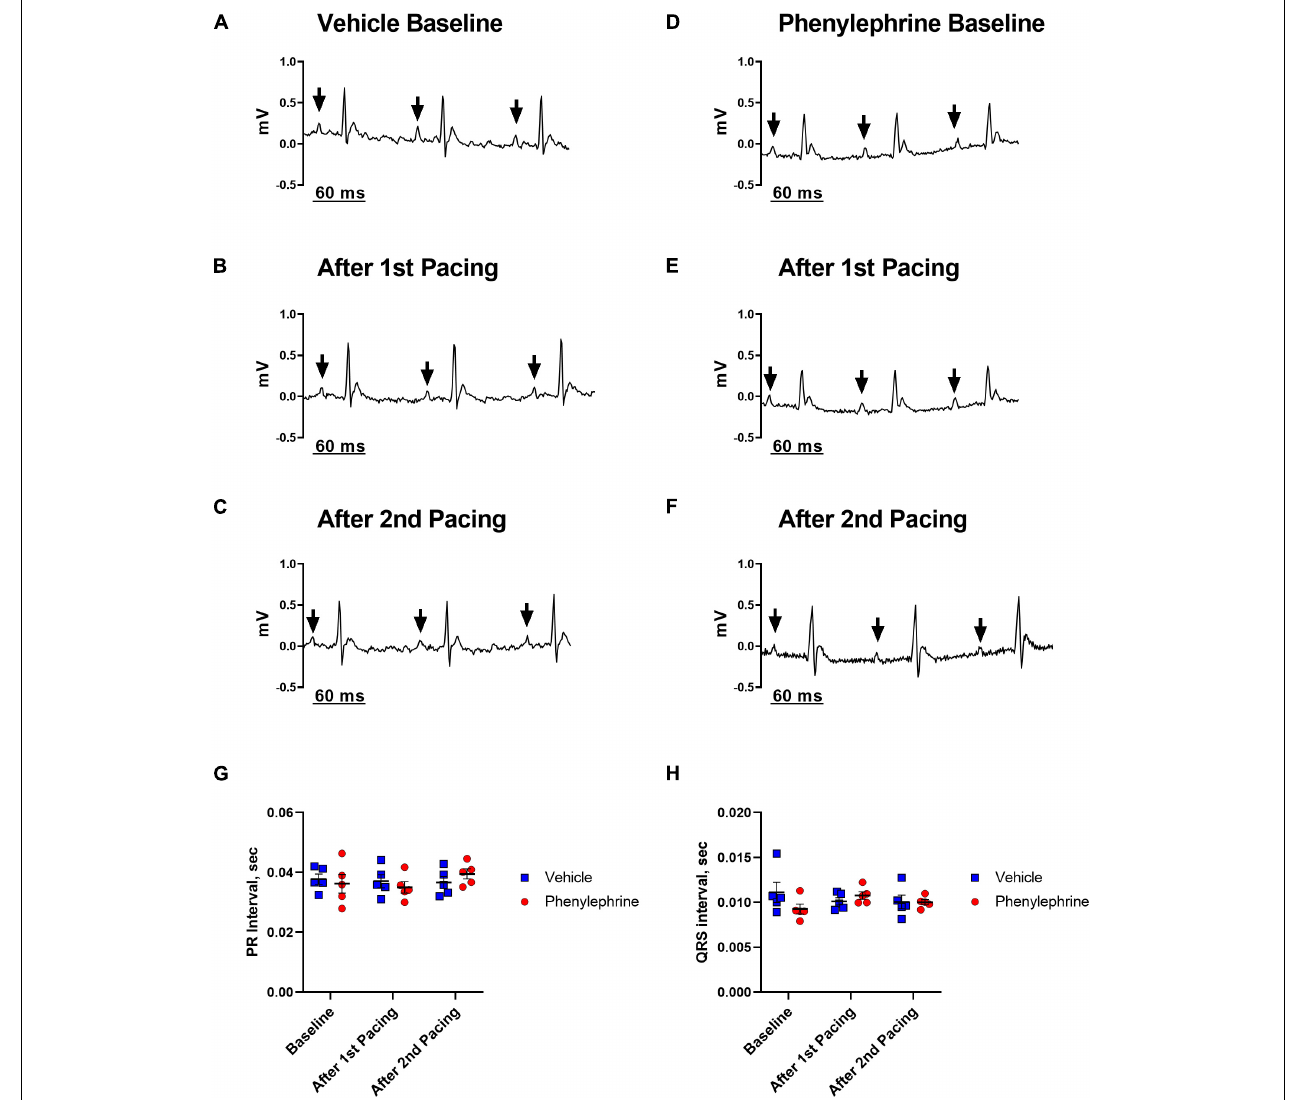
FIGURE 2 | Representative electrocardiograms (lead I) recorded prior to and after both the first and second pacing sessions for the vehicle (A–C) and phenylephrine groups (D–F) . Black arrows indicate P waves with consecutive QRS complexes, thus, describing sinus rhythm before and after electrical pacing of the heart. (G) There were no differences between the mean PR interval between vehicle and phenylephrine groups before and after both pacing sessions ( P = 0.92). (H) No differences in width of QRS complex were seen between the vehicle and phenylephrine groups ( P = 0.47). Data were compared with two-way ANOVA, n = 5.